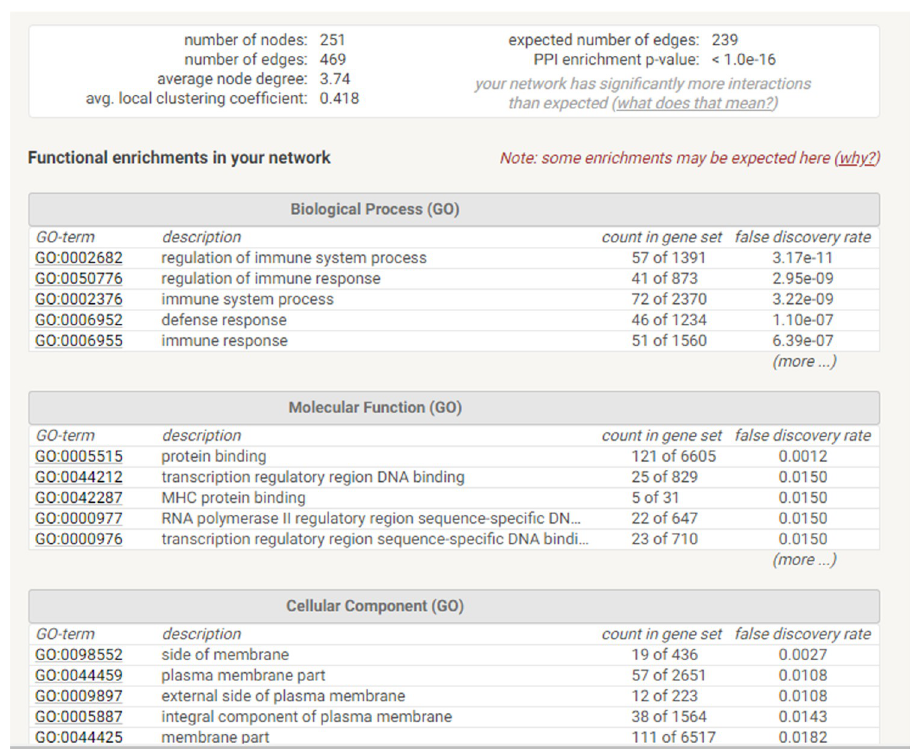
Fig 9. STRING network summary. The summary data are shown at the top and summarise the graphs in Fig 7.